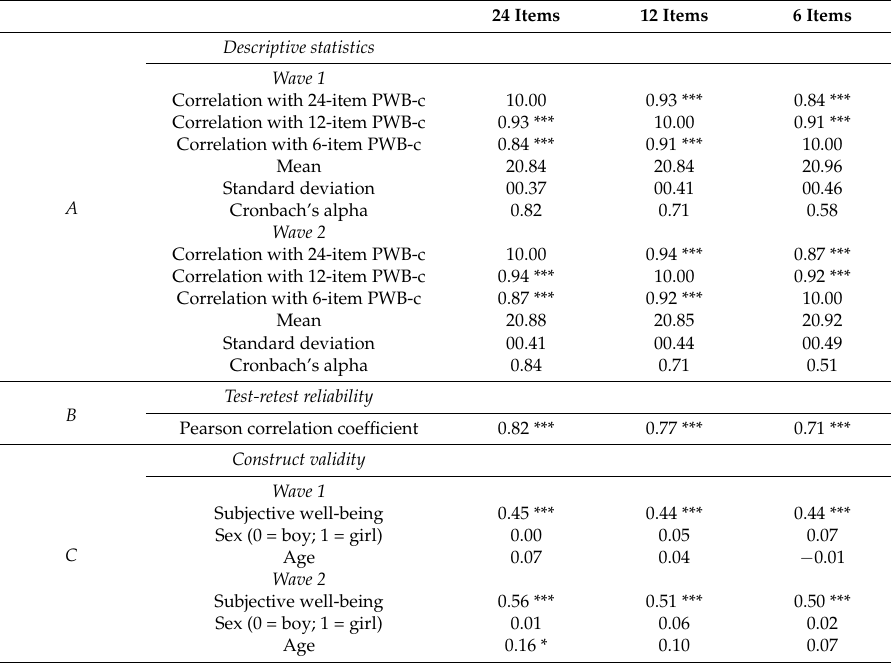
Table 1. Descriptive statistics, test-retest reliability, and construct validity of the psychological well-being scale for children observed in pilot ( N =